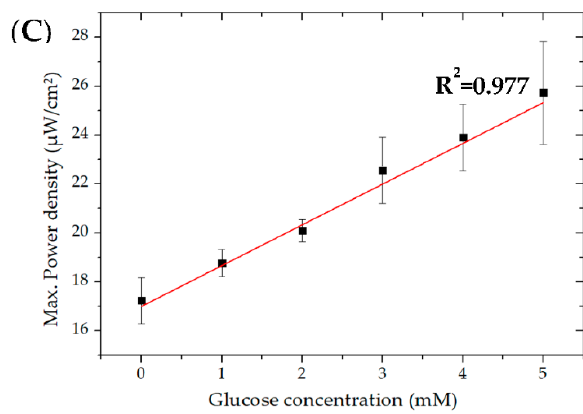
Figure 3. Polarization ( A ) and power density ( B ) curves of a microfluidic EBFC composed of a glucose oxidase (GOx)-attached bioanode and a laccase-attached biocathode operating in different glucose concentrations (0, 1, 2, 3, 4, and 5 mM). The arrows indicate increasing glucose concentration. ( C ) Corresponding calibration curve of the microfluidic EBFC (R 2 = 0.977).